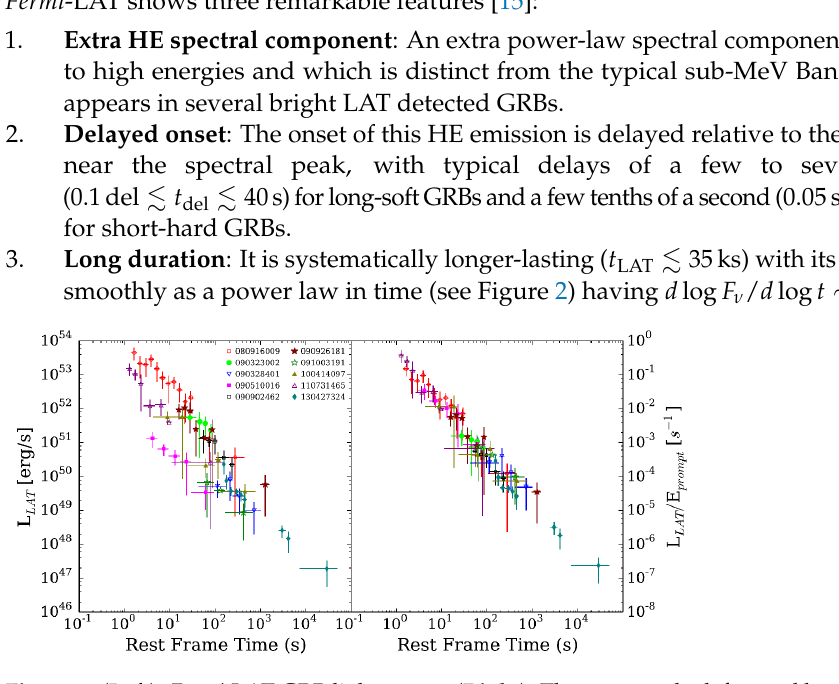
Figure 2. ( Left ): Fermi -LAT GRB lightcurves; ( Right ): The same as the left-panel but normalized